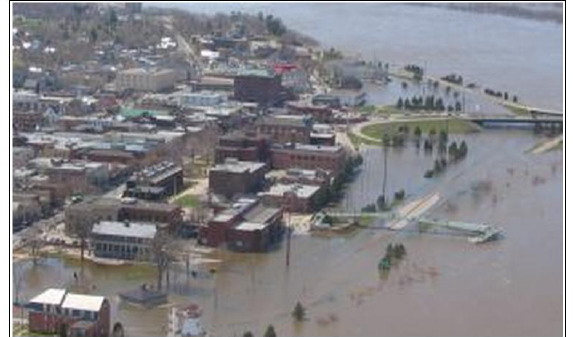
Figure 3 Fredericton downtown, May 1, 2008, second largest flood in recorded history. Source: City of Fredericton,